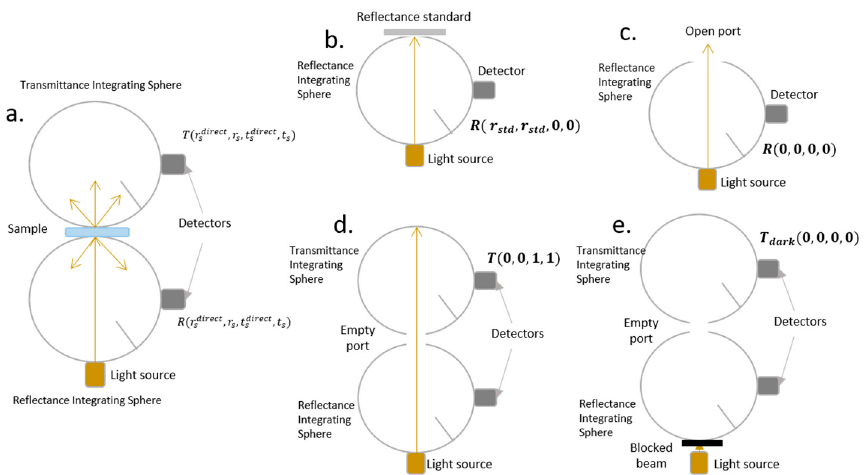
Figure 1. Schematic representation of the experimental setup depicting the double integrating sphere (DIS). ( a ) reflection and transmission measurements of the sample; ( b ) reflection measurement of the reflectance standard; ( c ) dark measurement for the reflection setup; ( d ) measurement with an empty port corresponding to 100% transmission and ( e ) dark measurement for the transmission setup.